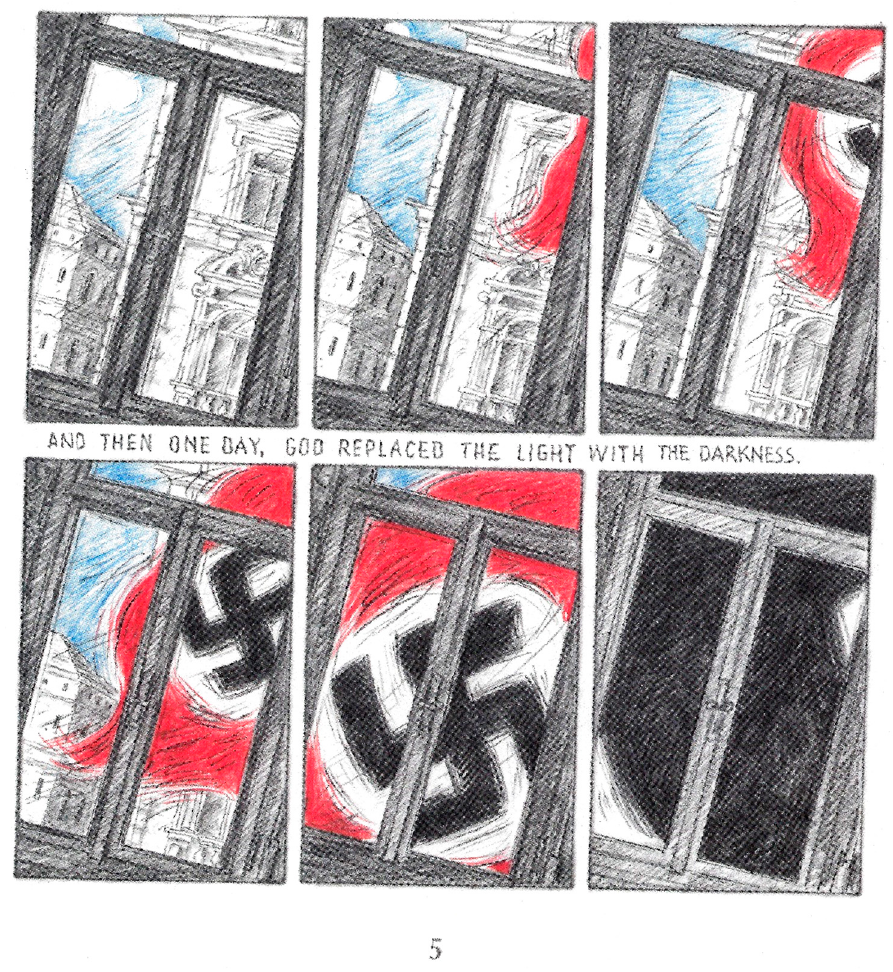
Figure 1. We Are On Our Own (Katin 2006). Reproduced by permission of Miriam Katin.